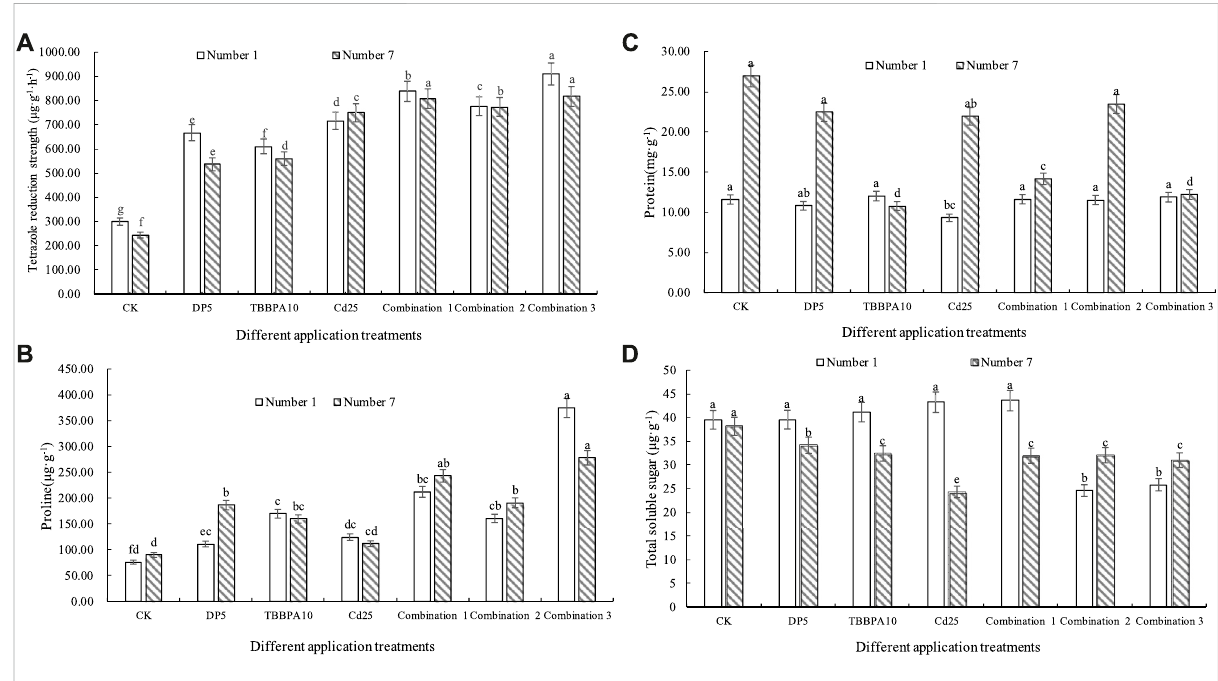
FIGURE 3 Effects of two halogenated fl ame retardants and cadmium on physiological and biochemical indexes of two kinds of rice seed germination. (A) The tetrazole reduction strength ( μ g · g -1 · h -1 ) in different application treatments. (B) The amount of proline ( μ g · g -1 ) in different application treatments. (C) The amount of protein (mg · g -1 ) in different application treatments. (D) The amount of Total soluble sugar ( μ g · g -1 ) in different application